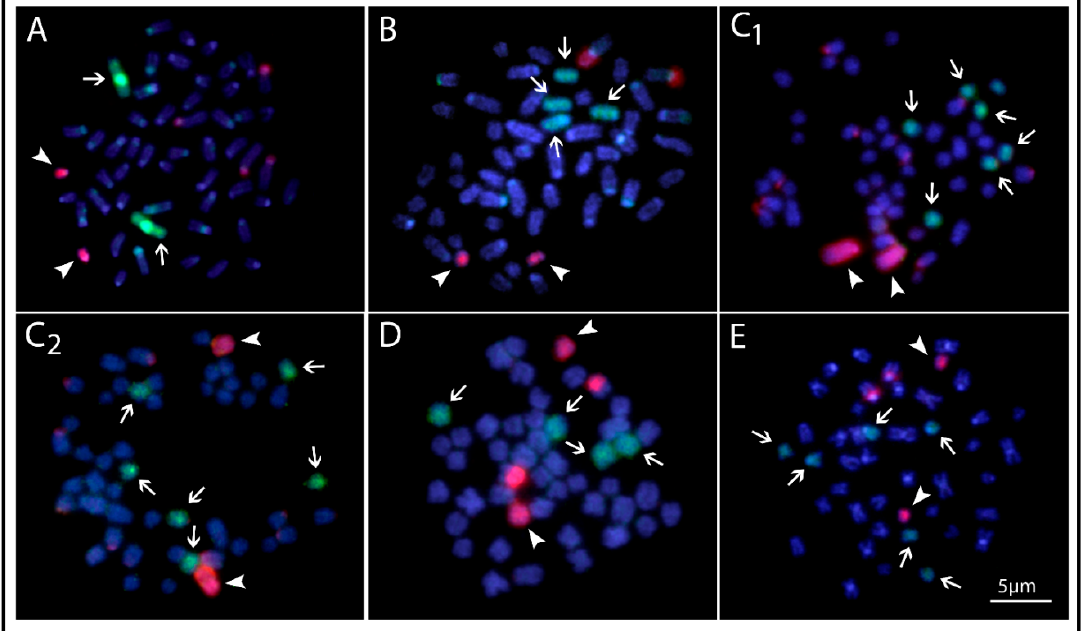
Figure 6. Zoo-FISH experiments with OFE-1 (arrows) and SFO-A (arrowheads) painting probes applied on the metaphase plate of the black arowana Osteoglossum ferreirai ( A ), silver arowana Osteoglossum bicirrhosum ( B ); Asian arowana Scleropages formosus that carries the conspicuous heterochromatic block in both ( C1 ) or just one ( C2 ) homologs; the Northern saratoga Scleropages jardinii ( D ) and Southern saratoga Scleropages leichardti ( E ). Bar = 5 µm.